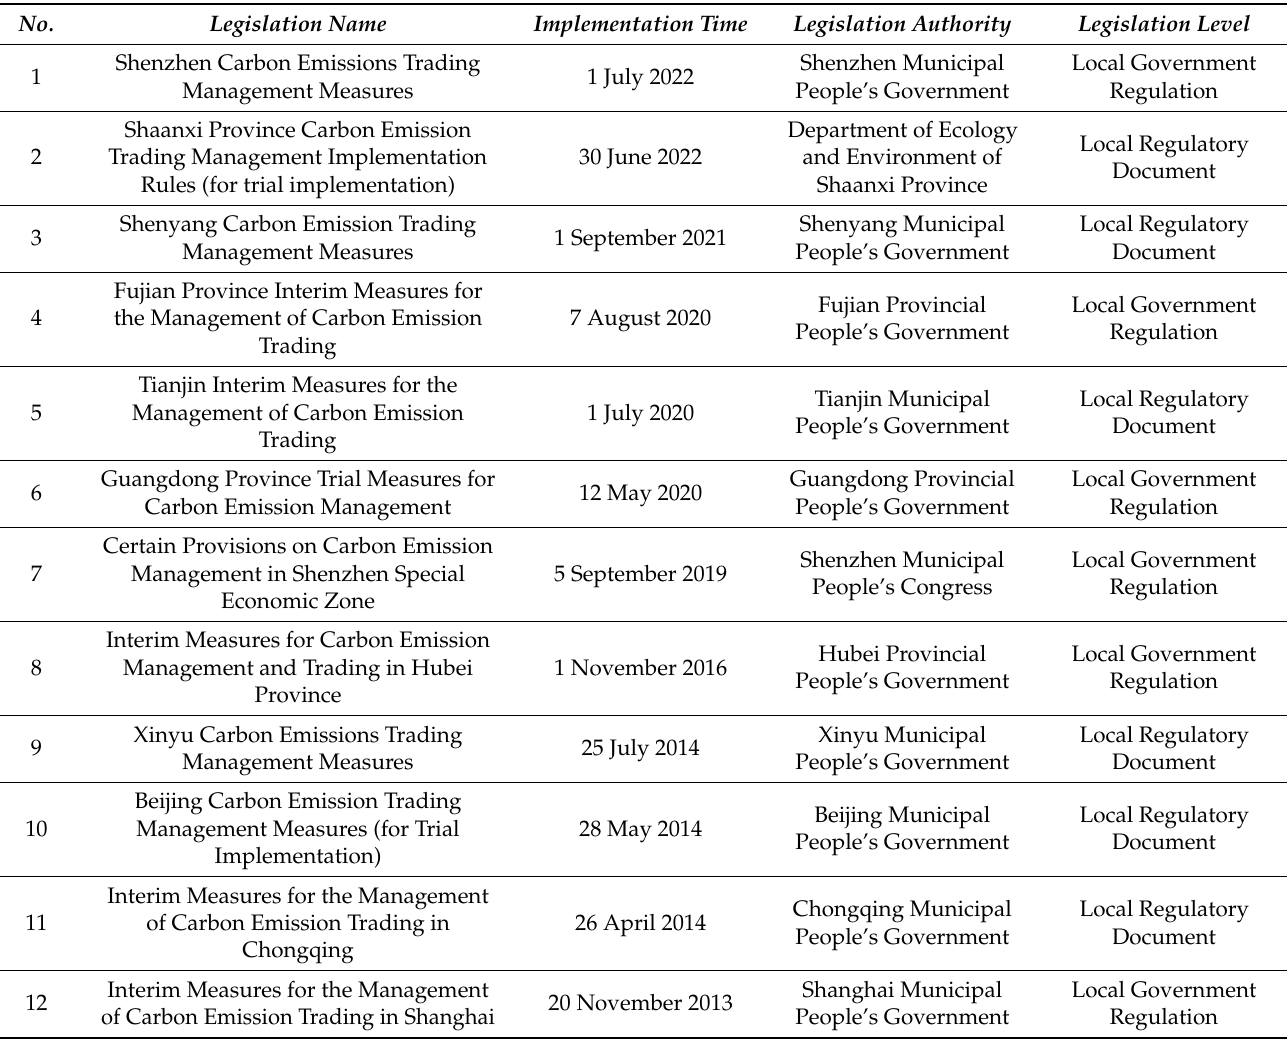
Table 1. Current legislation on carbon emissions trading management in major provinces and